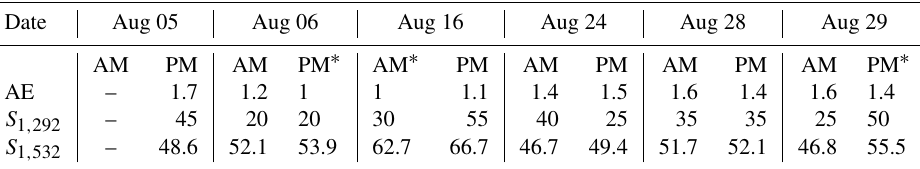
Table 1. The LMOL S 1 at 292nm ( S 1 , 292 ), HALO S 1 at 532nm ( S 1 , 532 ), and HALO AE (292 and 532nm) for August 2018. AM denotes morning, and PM denotes afternoon/evening.